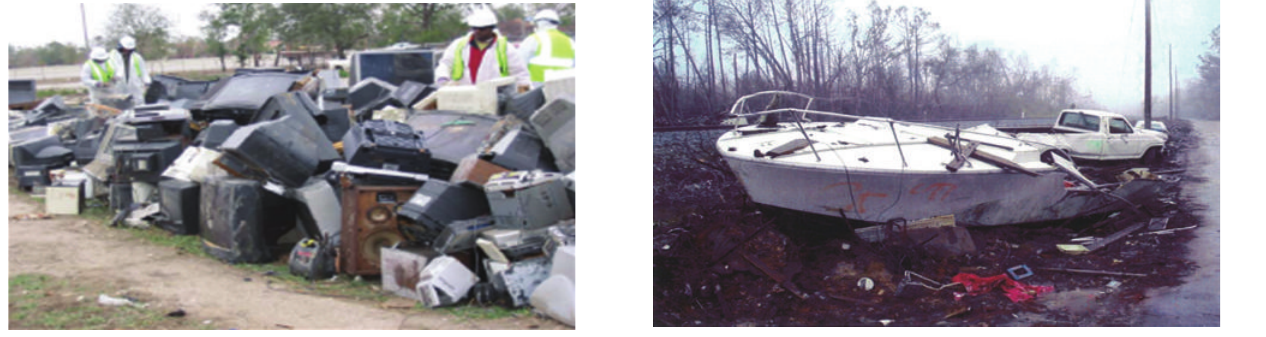
Figure 12: Vehicles and Vessel removed from Pass Christian,